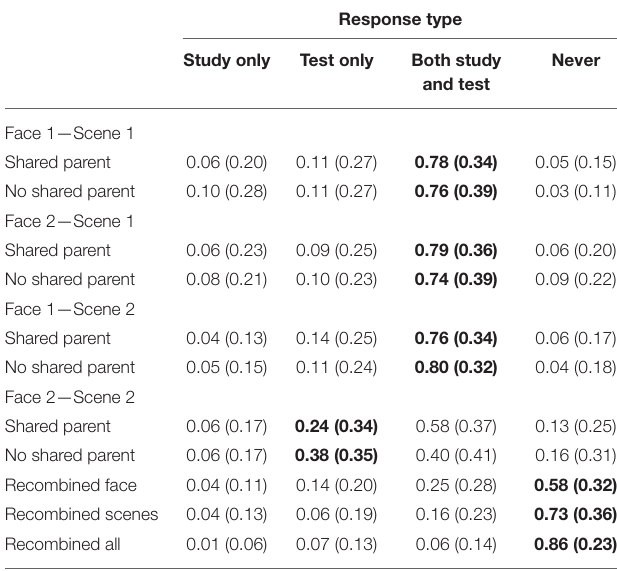
TABLE 1 | Experiment 1 source memory responses separated by pair-mate and trial